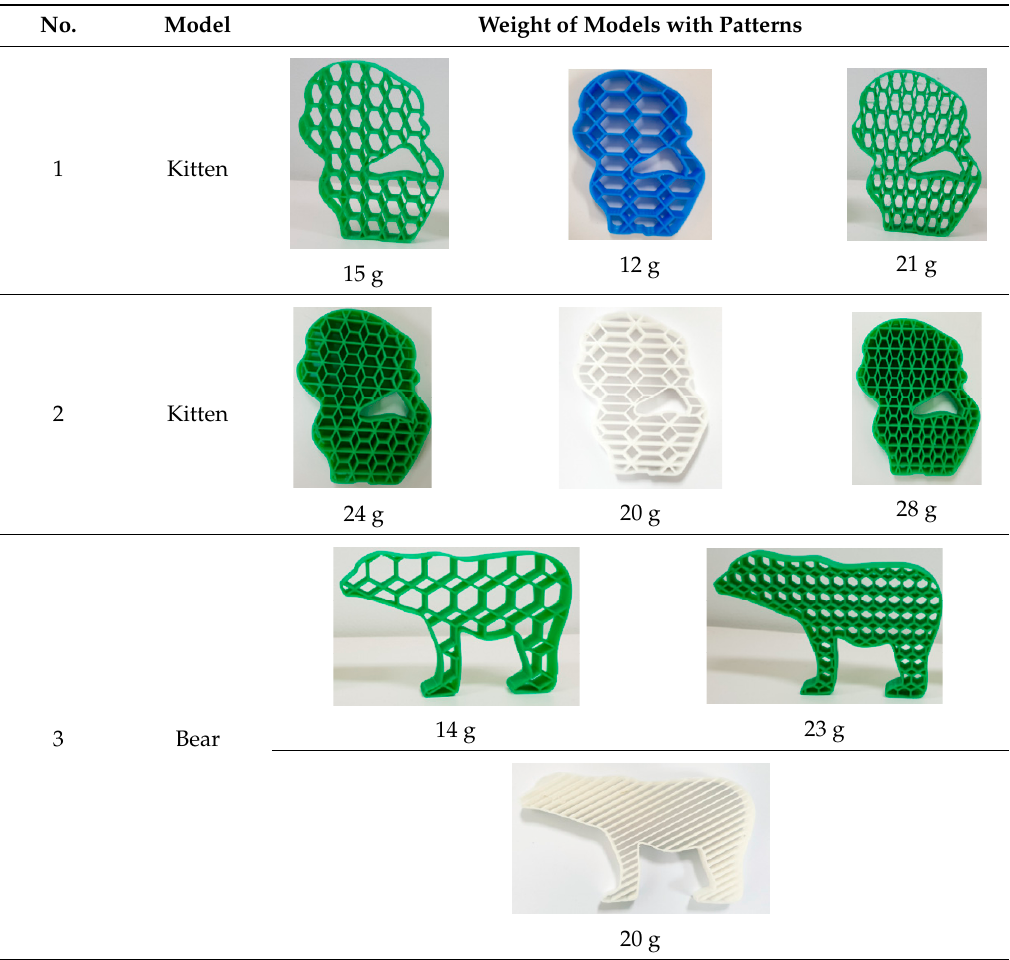
Table 1. Weight of Models with